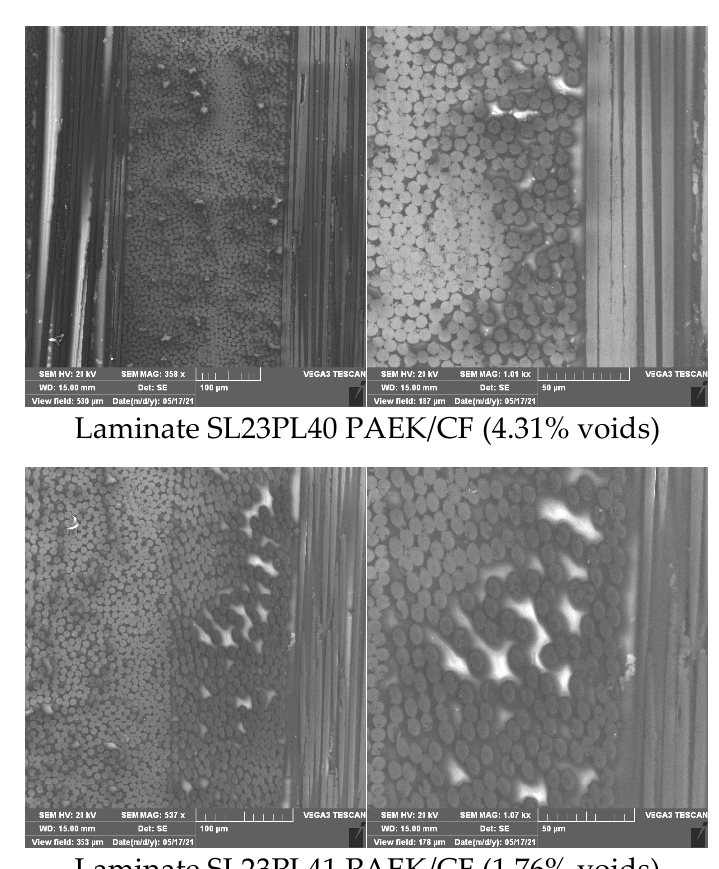
Figure 10. SEM images of the samples with PAEK resin.